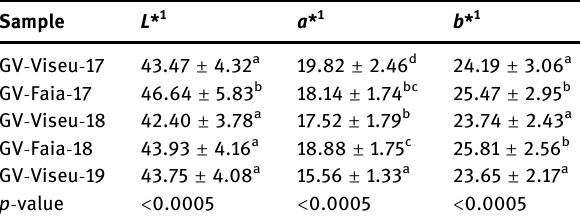
Table 7: Colour coordinates in the skin ( mean ± standard deviation